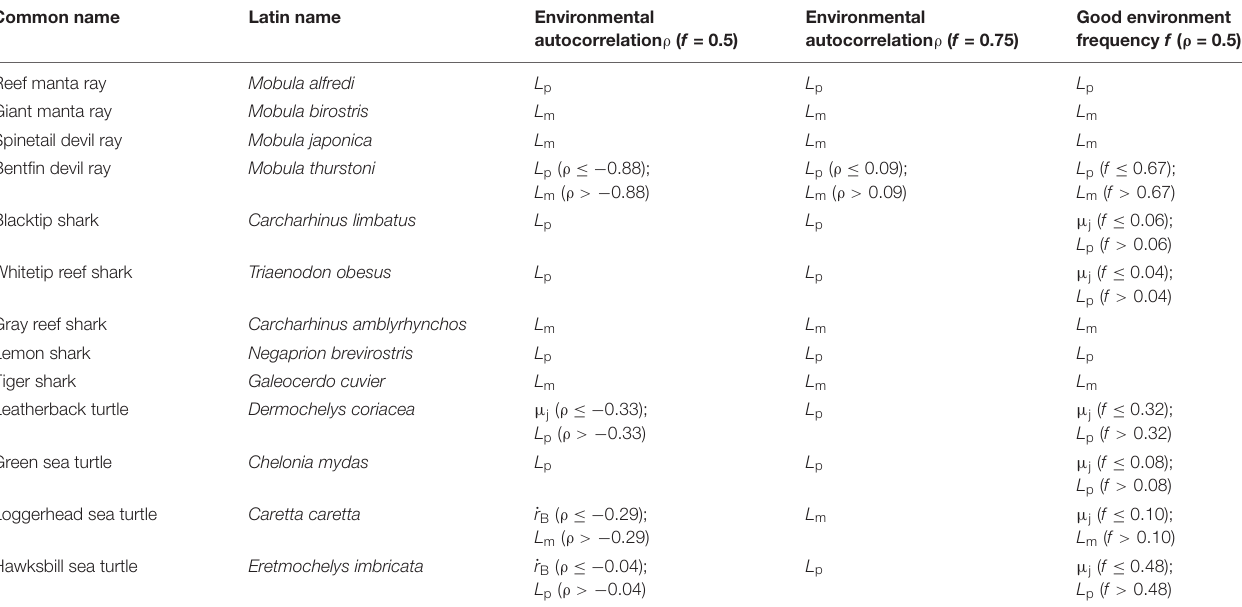
TABLE 3 | The elasticity of the log stochastic population growth rate, log( λ s ), to perturbation of life history parameters across the environmental autocorrelation gradient ρ and across the good environment frequency